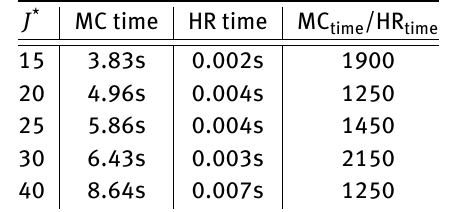
Table 4: Table containing the times to evaluate the DRC with the MC and HR methods and for different portfolio dimensions J * (the parameters β 0 , β 1 , β 2 were estimated once and for all). In the last column we indicate how many times the HR method results faster than the MC method. J * MC time HR